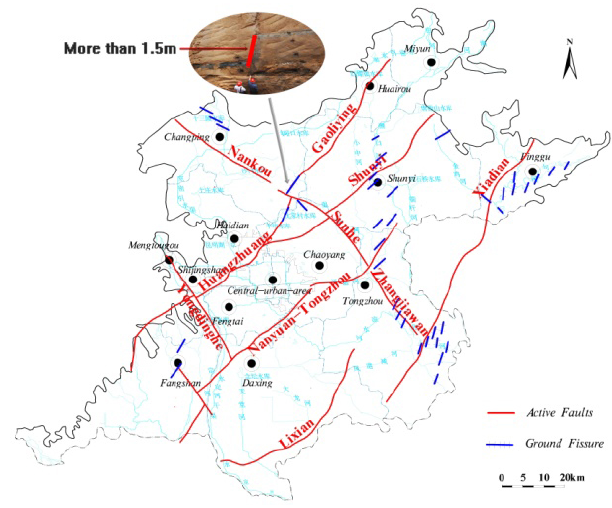
Figure 2. The distribution of ground fissures in the